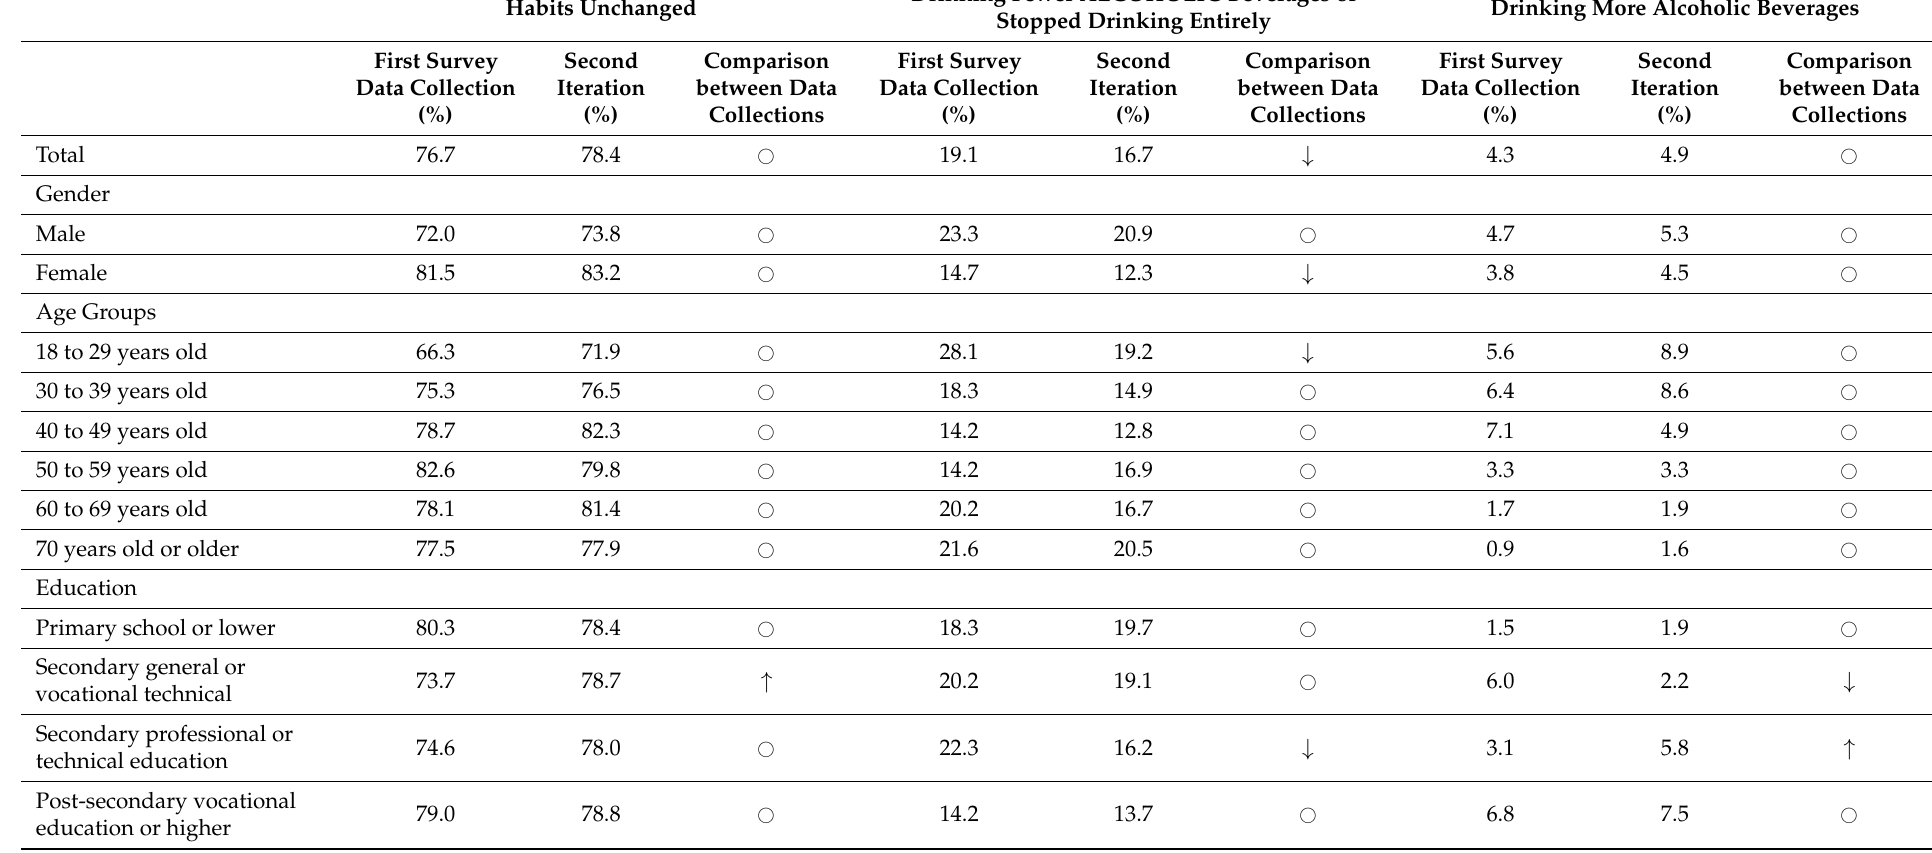
Table 2. Changes in drinking habits, related to respondents’ alcohol consumption in the past 12 months, between the first and second cross-sectional survey data collections. This includes the total and is according to the explanatory